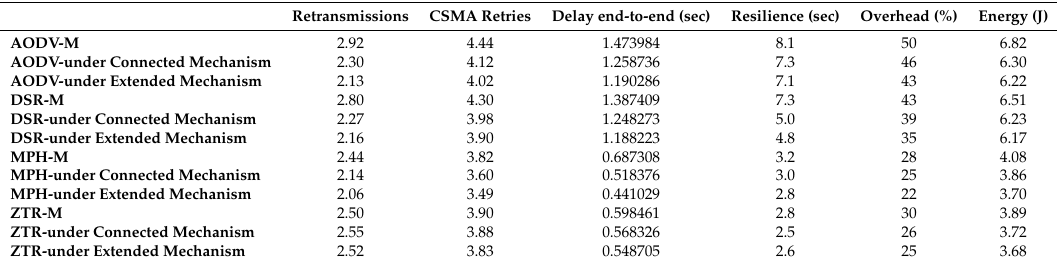
Table 6. Performance metrics under Extended Mechanism and Connected Mechanism for a non-uniform random